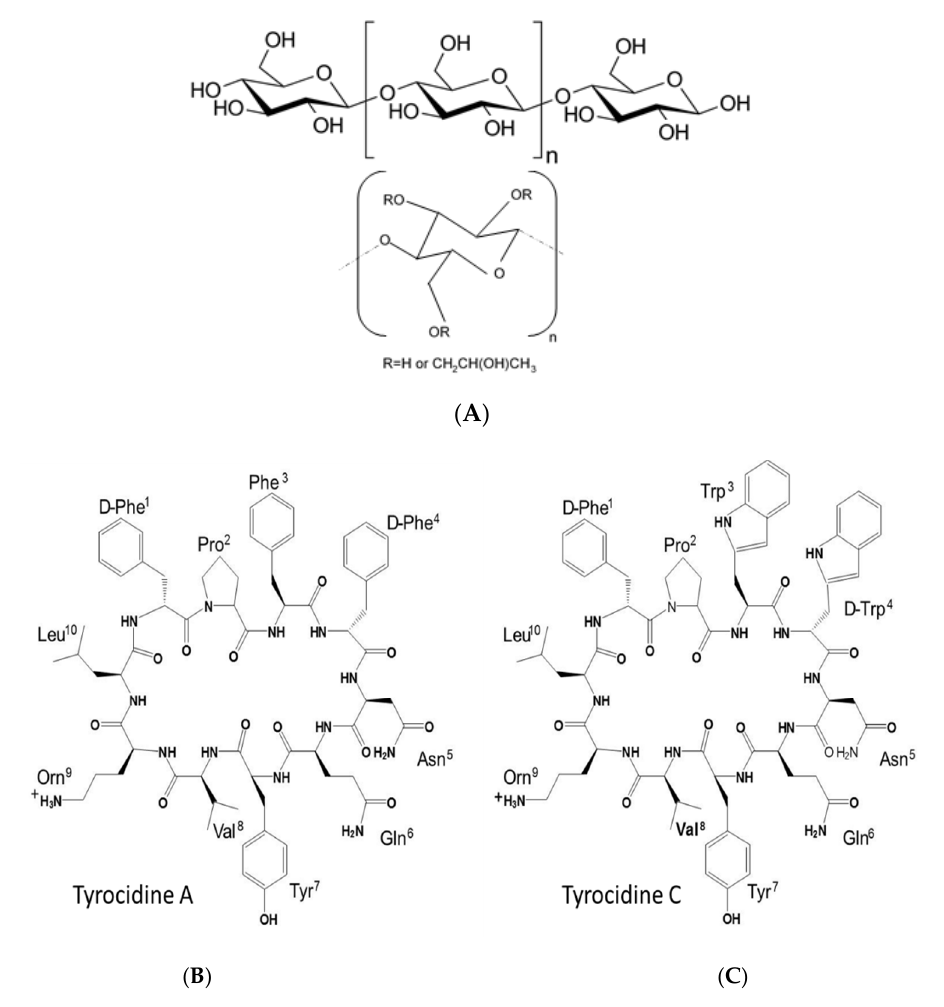
Figure 1. Examples of cellulose derivatives and Trcs studied with ( A ) cellulose polymer, ( B ) core of hydroxyl and methyl- cellulose derivatives and ( C ) primary structures of tyrocidine A and C. Table 1. Summary of commercial, modified cellulose derivatives utilised as formulants for the Trc mix in this study. Saccharide